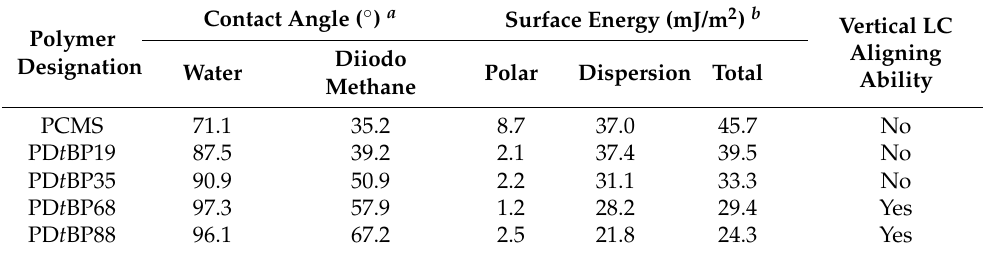
Table 2. Surface energy values and LC alignment